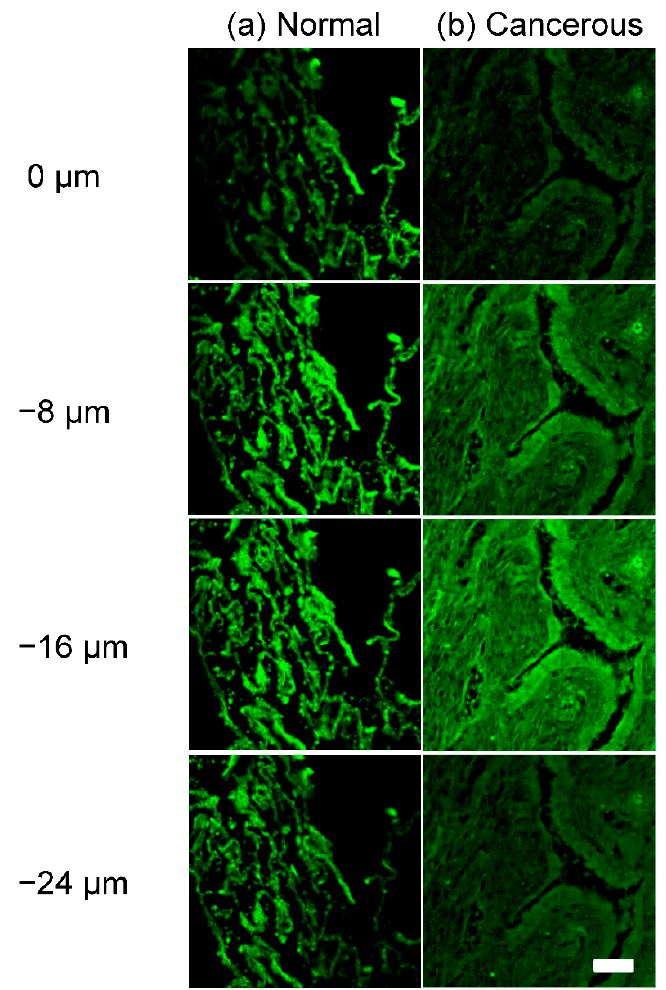
Figure 2. Autofluorescence 3D images of ( a ) normal (Video S1) and ( b ) cancerous (Video S2) lung tissues at different depths. Scale bar is 50 μ m.